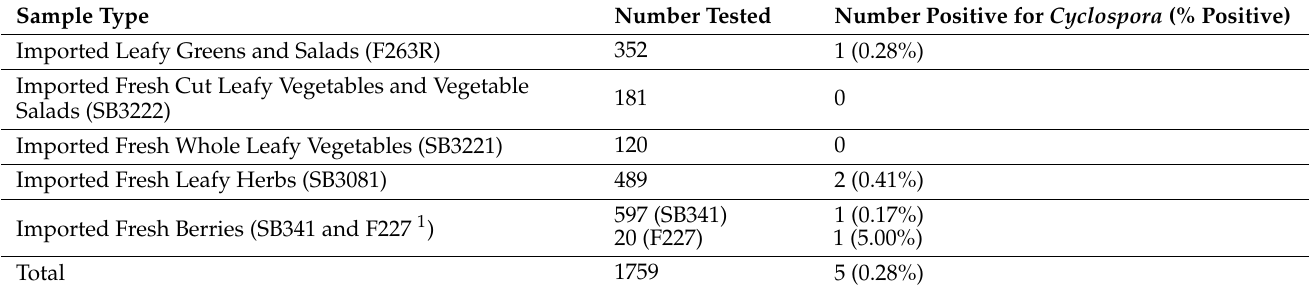
Table 7. Summary of the number and type of imported produce samples tested and confirmed positive for C. cayetanensis .